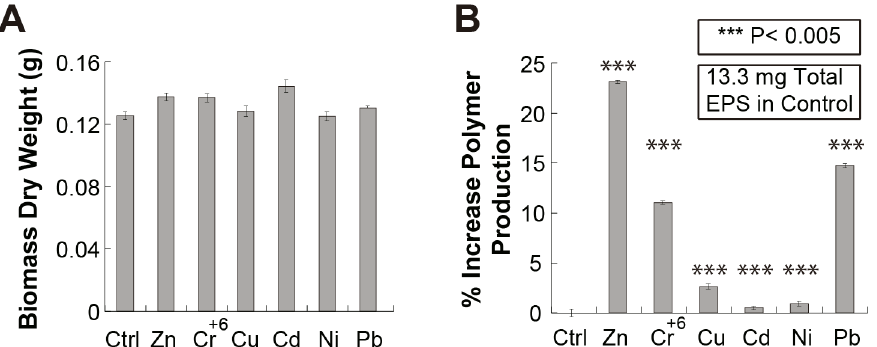
Fig 3. Quantitative Effect of Different Transition and Post-transition Metals in the Growth of Rhodotorula mucilaginosa strain UANL-001L and the Production of Exopolysaccharides. A) Dry biomass of Rhodotorula mucilaginosa strain UANL-001L (g) and B) Percentage Increase, compared to the control, in production of EPS, measured after growth in the presence of the different transition and post- transition metals (Cd(II), Pb(II), Zn(II), Ni(II), Cu(II) and